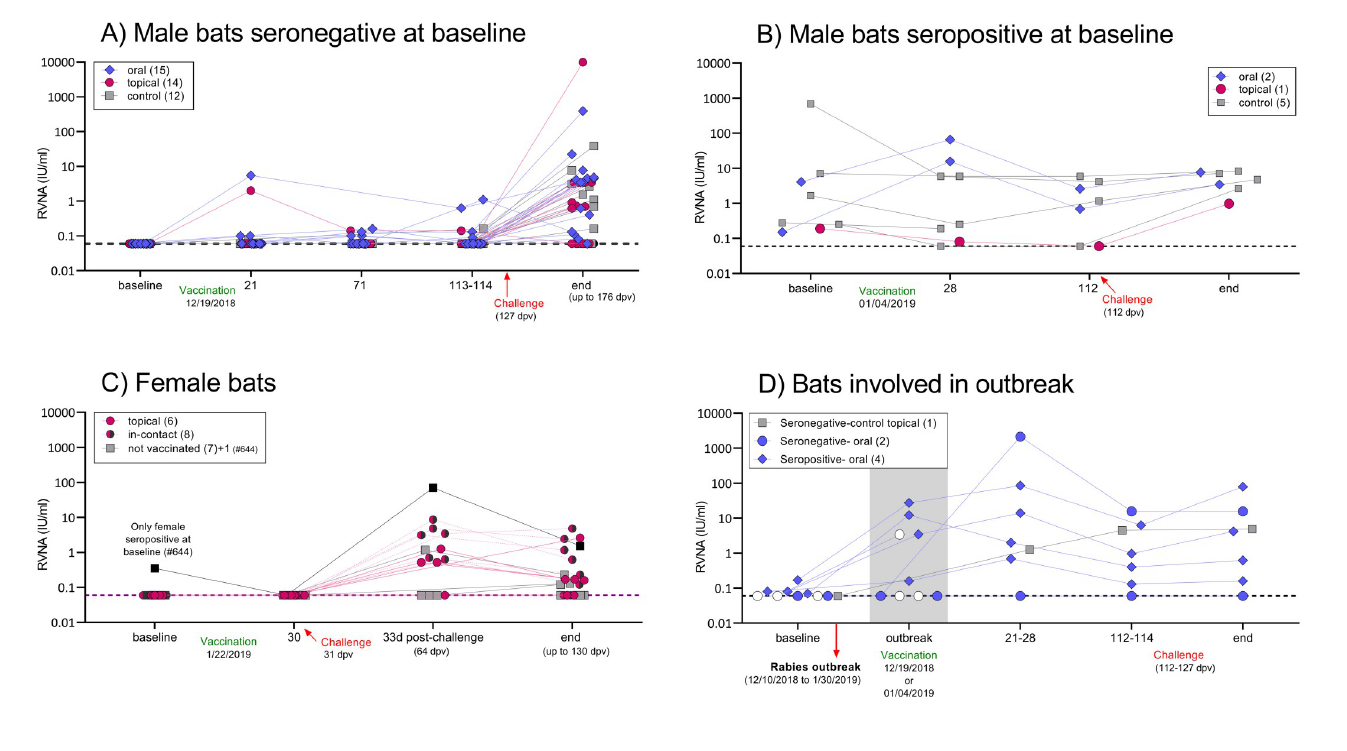
Fig 1. Detection of rabies virus neutralizing antibodies (RVNA) in individual vampire bats at different time points after vaccination and challenge with a heterologous (coyote) strain of RABV in A) male vampire bats seronegative at baseline, B) male vampire bats seropositive at baseline, C) females, showing an additional timepoint sample 33 days after challenge with cRABV, and D) bats that were involved in the natural rabies outbreak (RABV strain of vampire bat origin). In D, white-filled points represent three bats that died in the outbreak but were vaccinated and had a sample available for RVNA assessment. Events such as vaccination, the occurrence of a natural rabies outbreak within the captive colony, and the end of the study are indicated on the x-axis. Group size is indicated in parenthesis. The dotted line indicates the cut-off value of 0.06 UI/mL used in this study.